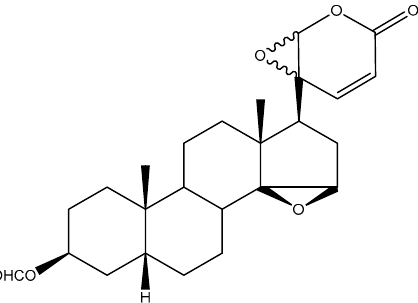
Figure 8. 20S,21-Epoxy-resibufogenin-3-formate (ERBF) inhibitor.